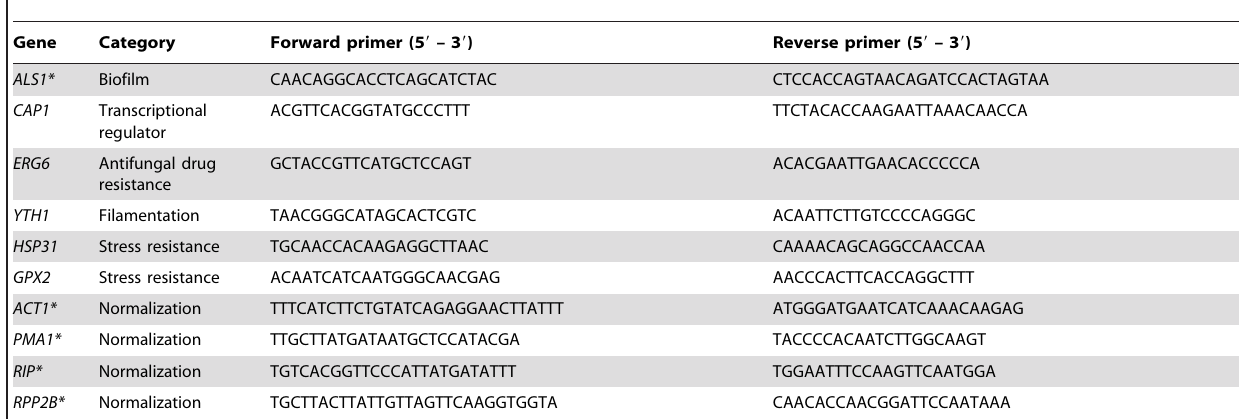
Table 1. Primers used for qRT-PCR